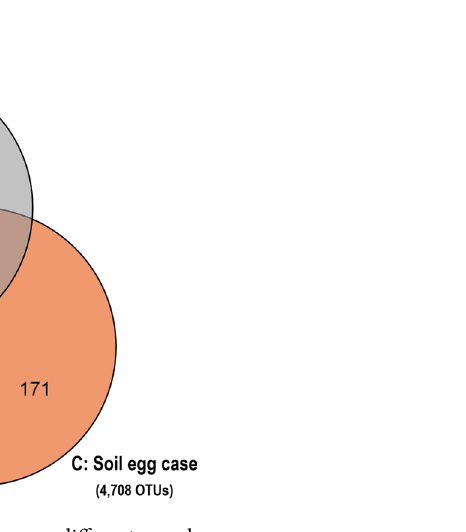
Figure 2. Comparison of OTUs numbers among different